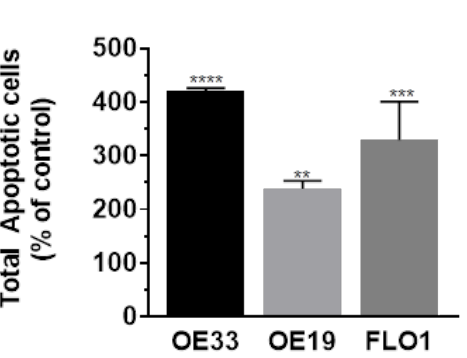
Figure 2. Induction of programmed cell death in resveratrol-treated OE33, OE19 and FLO-1 cells. OE33 cells were seeded at a density of 62,500 cells/well in 12-well plates, treated with resveratrol at an IC 50 concentration of 100 µ M for 72 h. Three independent experiments were performed. ( A ) Representative scatter plot of Muse Annexin assay for control OE33 group. ( B ) Representative scatter plot for Muse Annexin assay for resveratrol-treated OE33 group. ( C ) The profiles (% gated) of the control group and treated group. Similar to OE33 cells, OE19 and FLO-1 cells were treated with resveratrol at the IC 50 concentration of 50 and 40 µ M, respectively. ( D ) Representative scatter plot of four independent trials of the OE19 control group is shown. ( E ) The OE19 resveratrol-treated group. ( F ) The profiles (% gated) of the control group and the treated group of OE19 cells. Four independent trials were also performed for FLO-1 cells. ( G ) Representative scatter plot of the control FLO-1 cells and ( H ) treated FLO-1 group. ( I ) The % gated profiles of the FLO-1 control group and the treated group. ( J ) On normalizing to the control group, the percent of apoptotic cells in the treated group are represented by a bar graph for each cell line. The p -value was calculated for each cell line. * Represents p -value < 0.05. More asterisks represent values of higher statistical